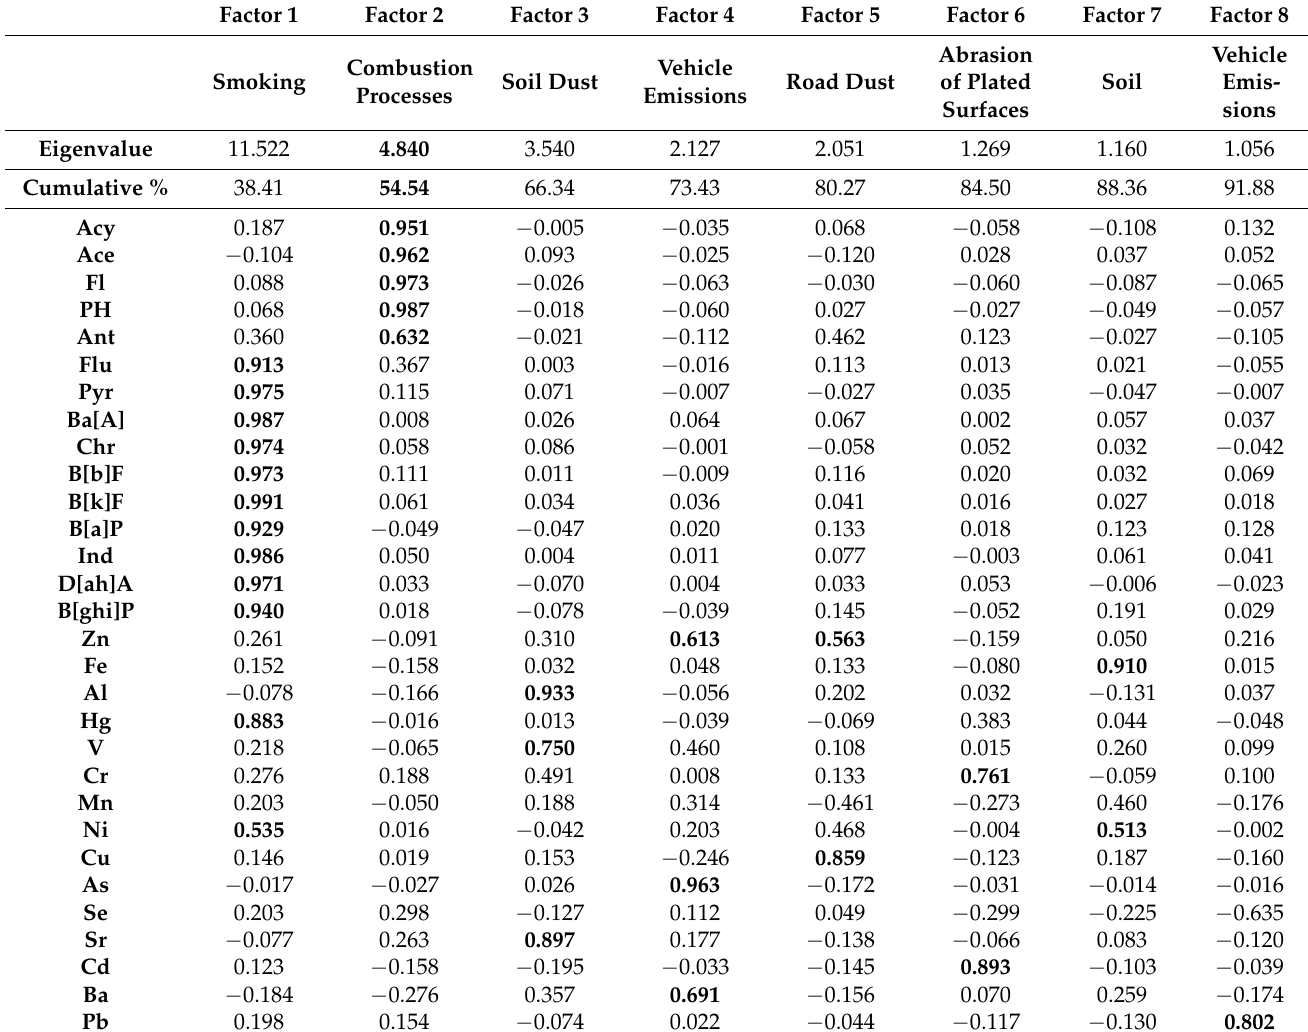
Table 3. Results of Principal Component Analysis